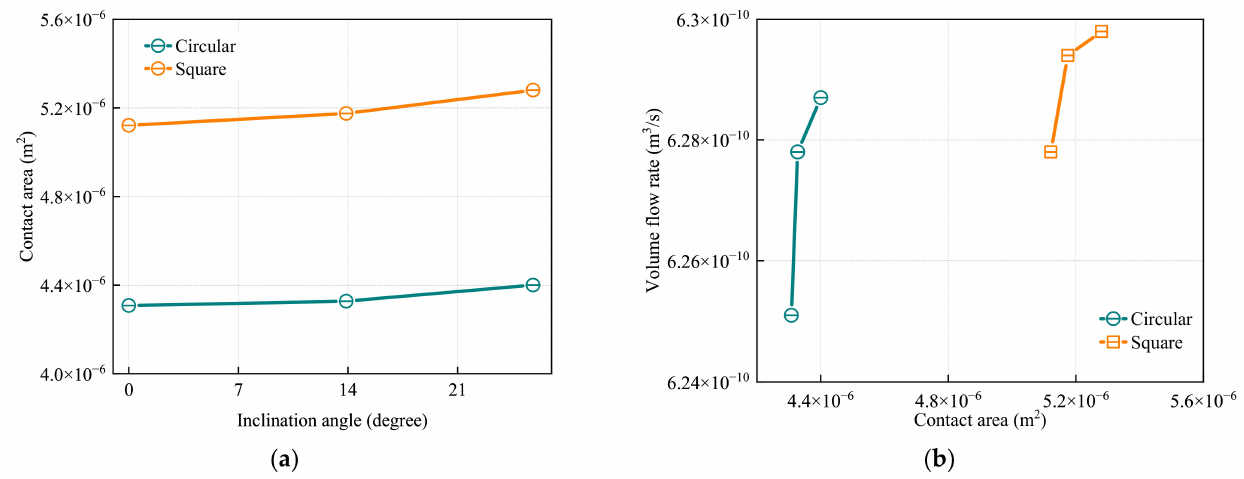
Figure 18. ( a ) Contact area vs. inclination angle for slanted microchannel models with a 16 pixel 2 (0.1279 mm 2 ) circular microchannel and a 16 pixel 2 (0.1279 mm 2 ) square microchannel, respectively; ( b ) volume flow rate vs. contact area for slanted microchannel models with a 16 pixel 2 (0.1279 mm 2 ) circular microchannel and a 16 pixel 2 (0.1279 mm 2 ) square microchannel, respectively.